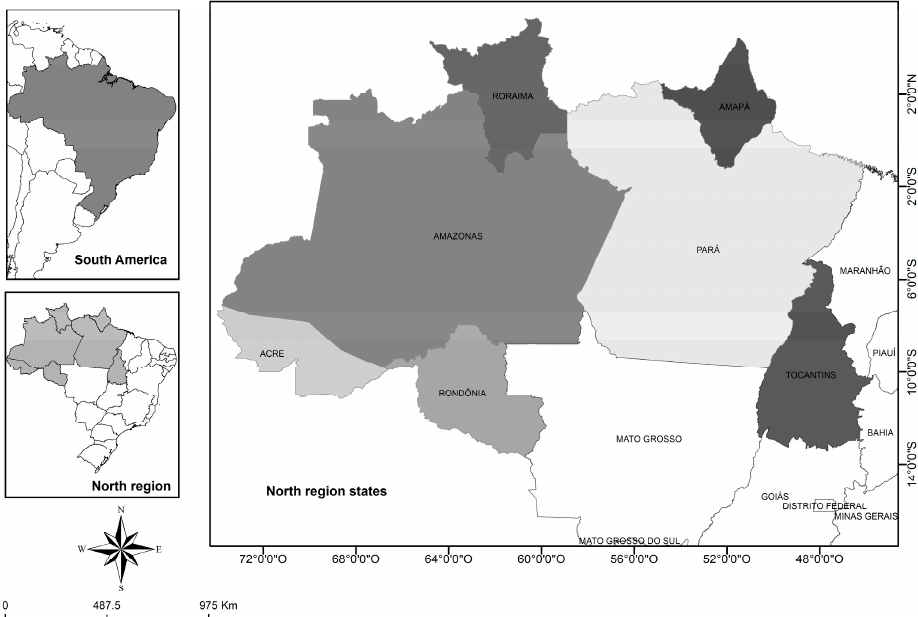
Figure 1. Study scenario—states in the North region of